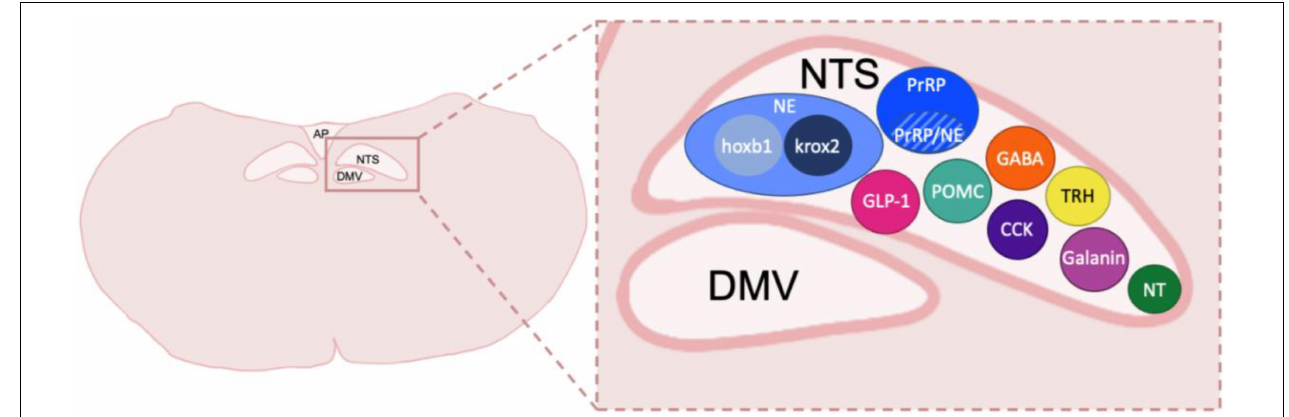
FIGURE 1 | Neuronal types and subtypes in the NTS. Schematic coronal medullary section showing the diversity of cell types located within the NTS. Peptide and transmitter expression includes NE, norepinephrine, which is made up of cellular subtypes hoxb1 and krox2; prolactin-releasing peptide, PrRP which also has a population of neurons that co-express NE; GLP-1, glucagon-like peptide 1; POMC, pro-opiomelanocortin; GABA, gamma-aminobutyric acid; CCK, cholecystokinin; TRH, thyrotropin-releasing hormone; Galanin; NT, neurotensin. Other peptides shown to be in the DVC but not depicted include Met-enkephalin, Dynorphin, Substance P, calcitonin gene related peptide and Neuropeptide Y. NTS, nucleus of the tractus solitarius; DMV, dorsal motor nucleus of the vagus nerve; AP, area postrema. Sizes not to scale or indicative of typical location within a caudal DVC section.